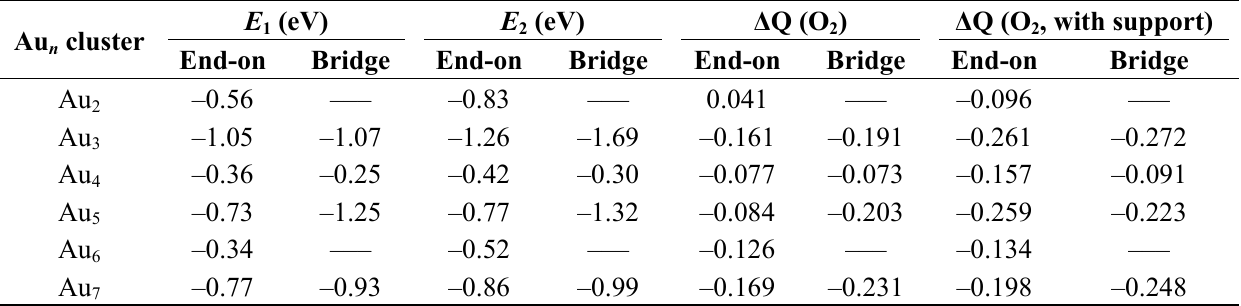
Table 3. Calculated adsorption energies, E O molecule in the most stable “end-on” and “bridge” adsorption with and without 2 N-graphene